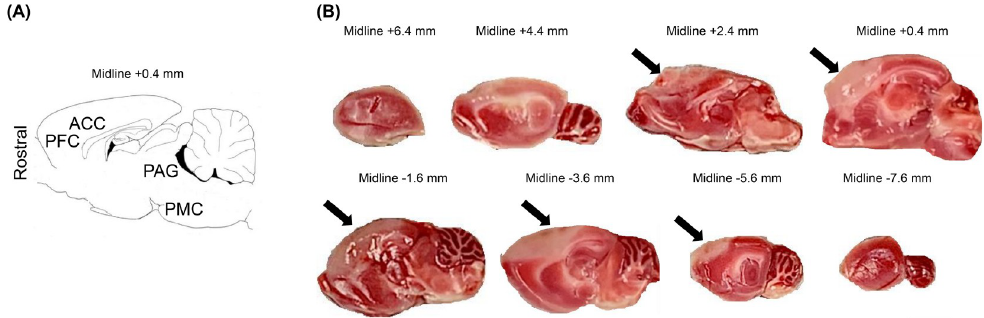
Fig 2. Diagrammatic representation of a sagittal section and triphenyl tetrazolium chloride (TTC)-stained brain images. A: Anterior cingulate cortex (ACC), prefrontal cortex (PFC), periaqueductal gray (PAG), and pontine micturition center (PMC) are present in the sagittal section 0.4 mm lateral to the midline identified according to the rat brain atlas of Paxinos and Watson. B: Examples of TTC-stained sagittal sections of rat brain on Day 1 after photothrombosis. Cerebral infarction was identified in PFC and ACC in the brains of all rats after photothrombosis. Arrows indicate unstained areas (areas of cerebral infarction). The distances from the midline are shown above each brain slice. Scale bars = 3 mm.